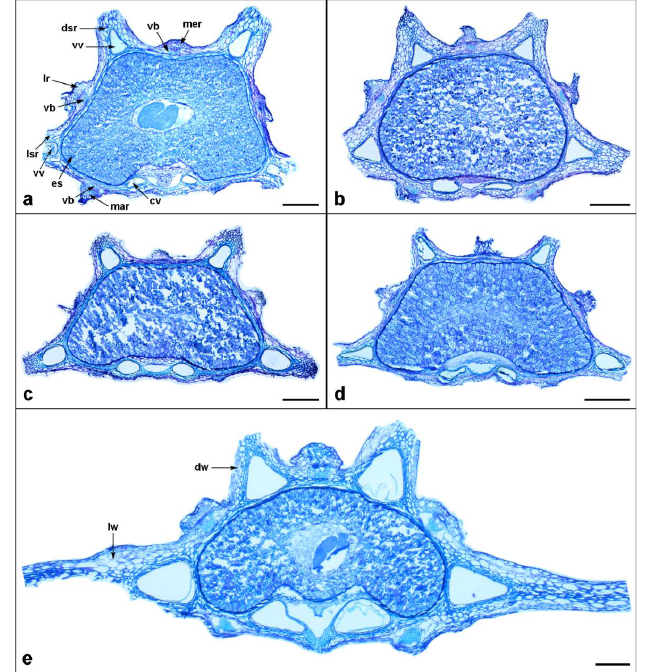
Figure 5. Mericarp structure of the investigated Daucus taxa, as seen in a transverse section. ( a ) D . involucratus ; ( b ) D . pusillus ; ( c ) D . sahariensis ; ( d ) D . syrticus ; ( e ) D . rouyi . Abbreviations: cv, commissural vitta; dsr, dorsal secondary rib; dw, dorsal wing; es, endosperm; lr, lateral primary rib; lsr, lateral secondary rib; lw, lateral wing; mar, marginal primary rib; mer, median primary rib; vb, vascular bundle; vv, vallecular vitta. Scale bar = 200 µm.